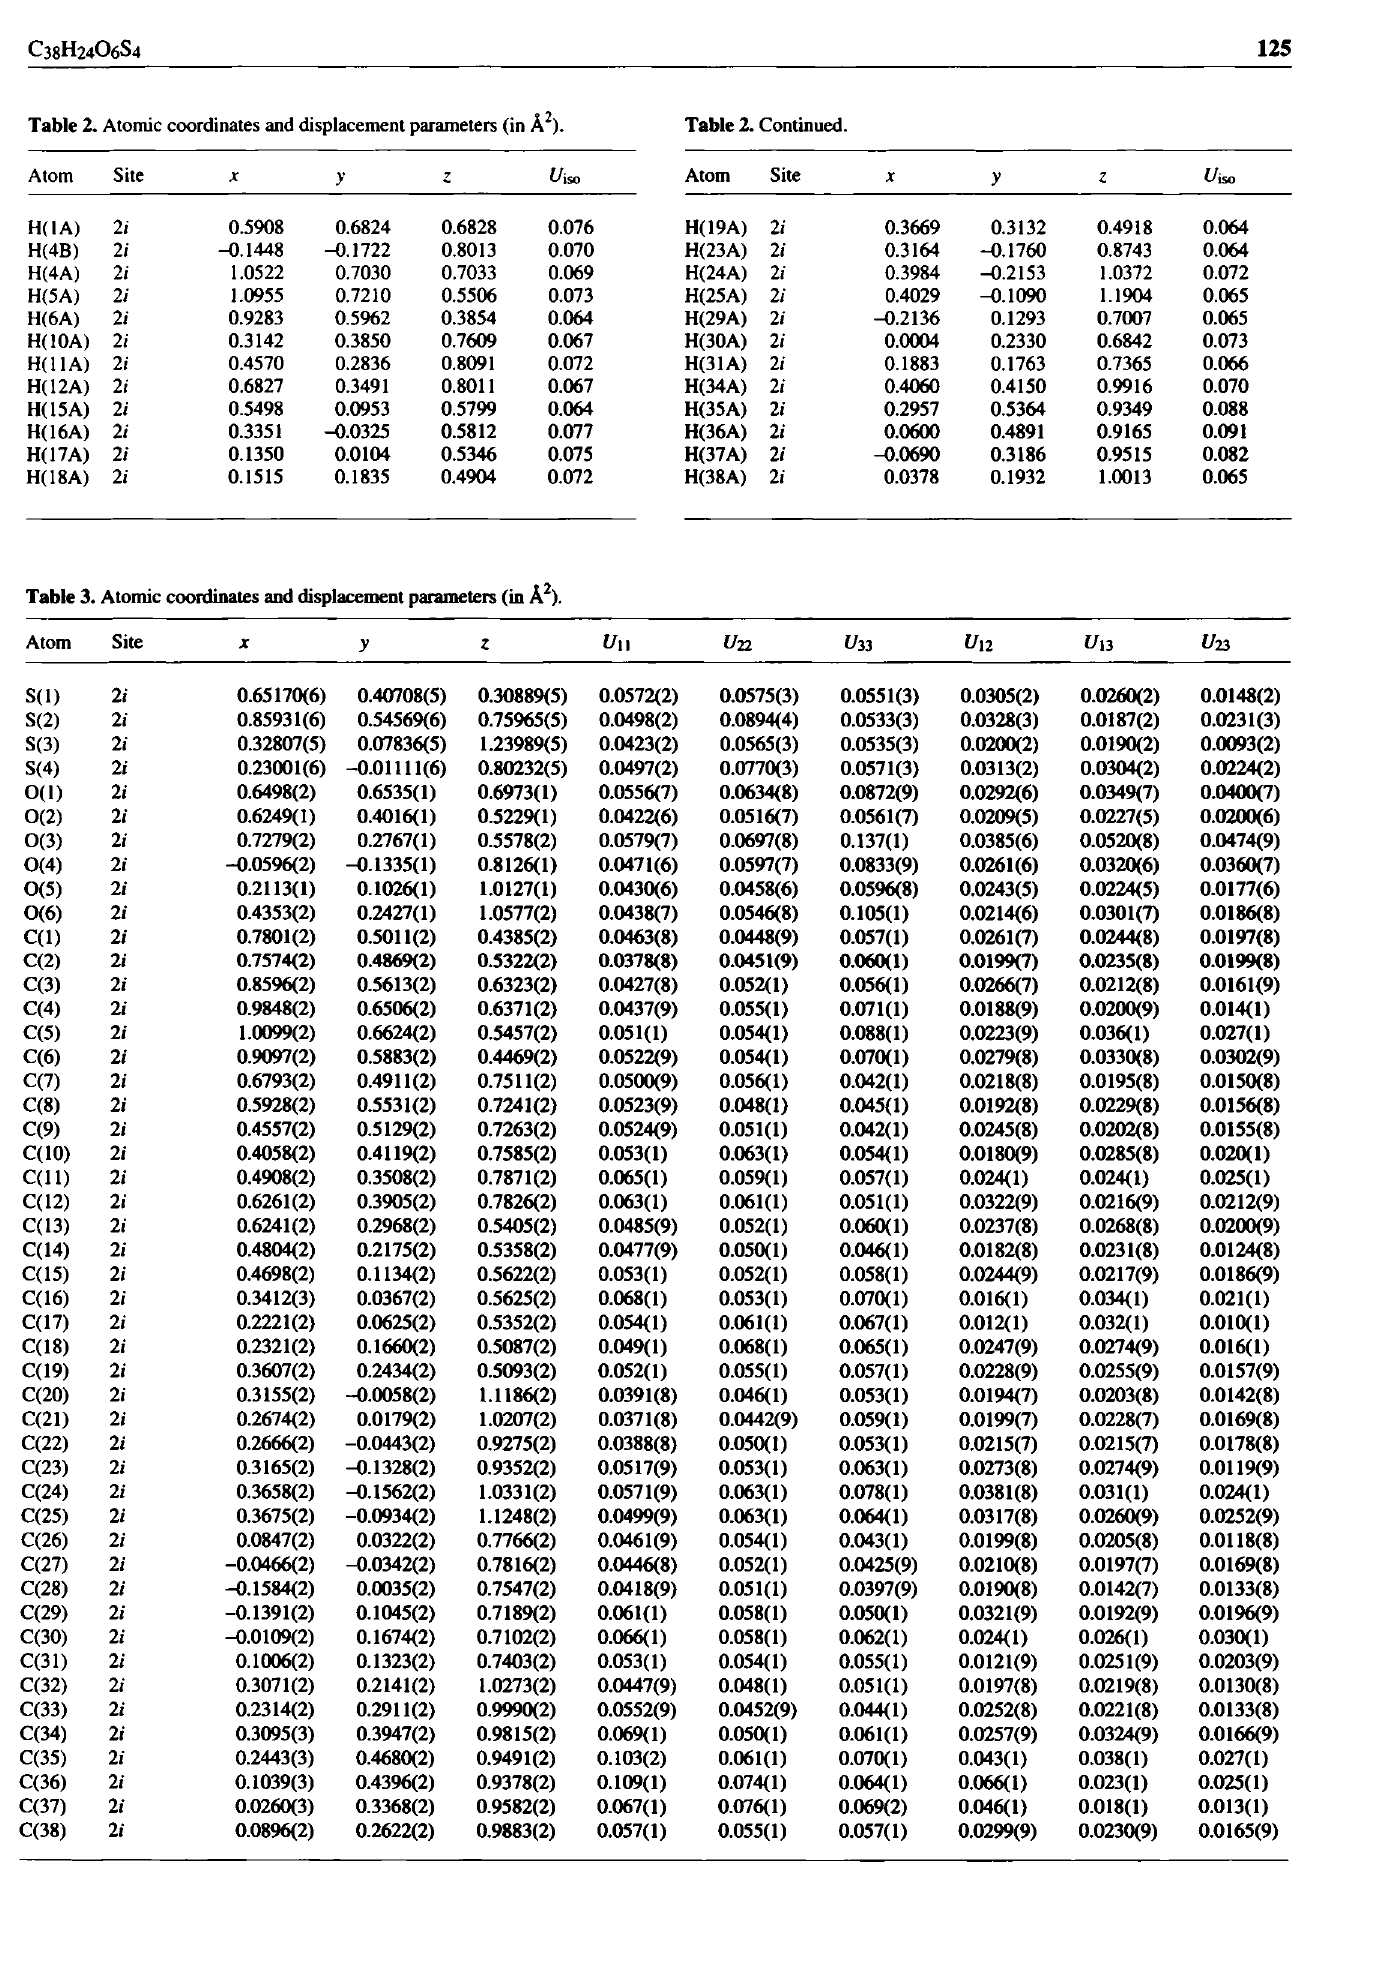
Table 2. Atomic coordinates and displacement parameters (in Â 2 ).